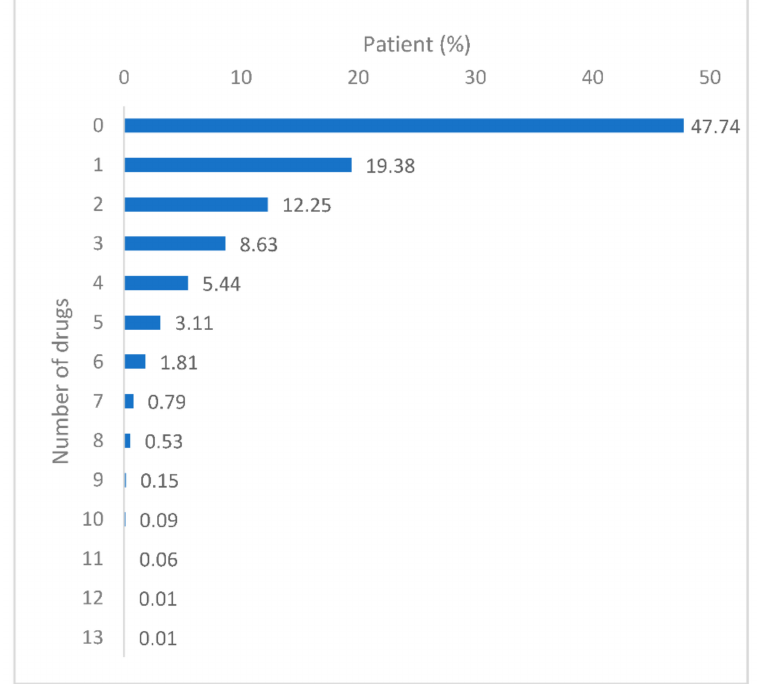
Figure 1. Patient proportions for the number of drugs used.